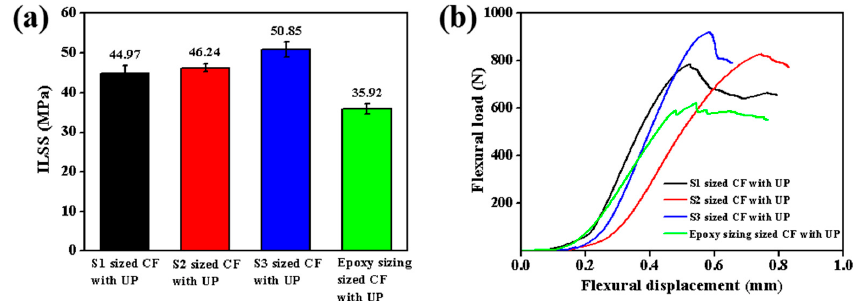
Figure 11. ILSS of the CF/UPR composites ( a ), and Load-displacement curves of CF/UPR composite ( b ).